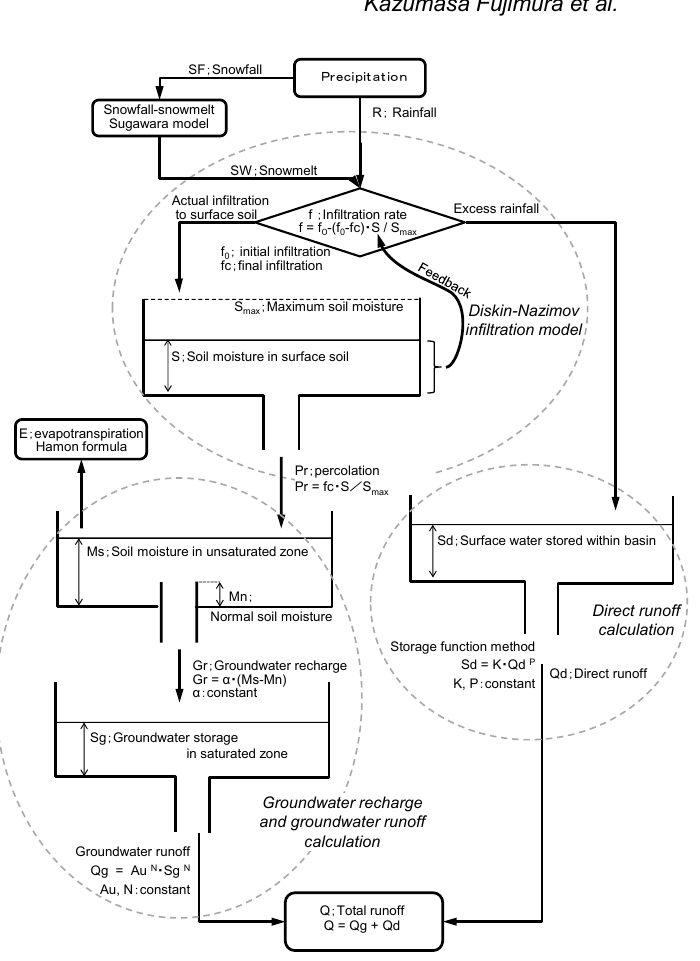
Fig. 3 Simplified schematic of the hourly hydrological model.